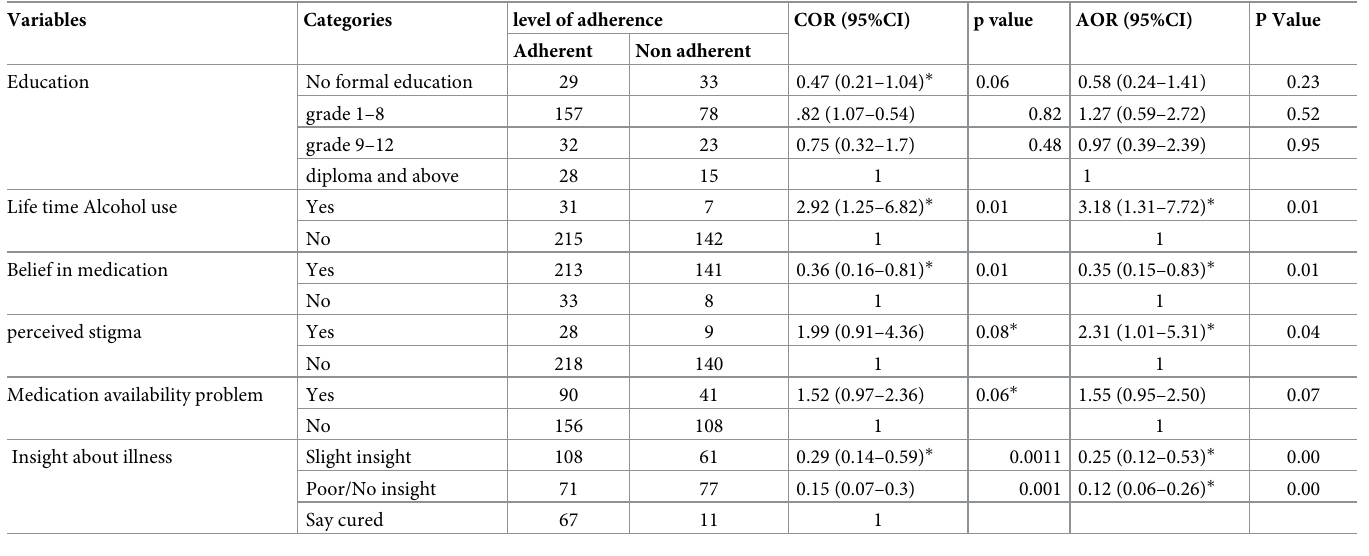
Table 6. Multivariate logistic regression model for selected factors with treatment adherence status of respondents at Asella Referral and Teaching Hospital